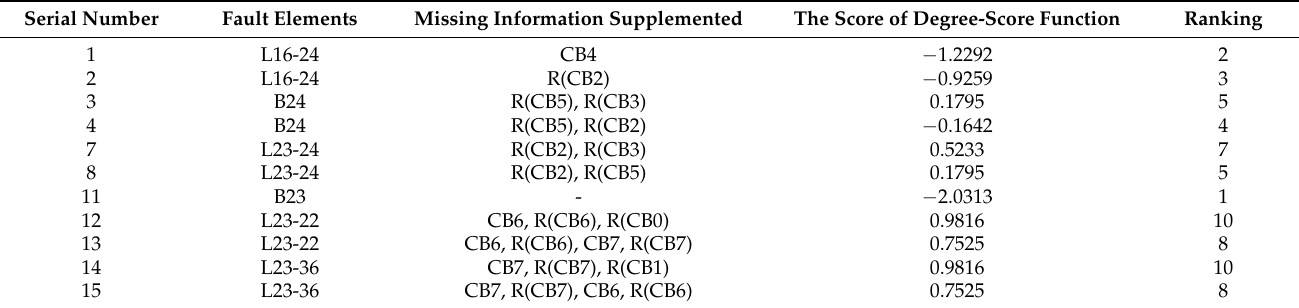
Table 8. Results sorted with DFTS.